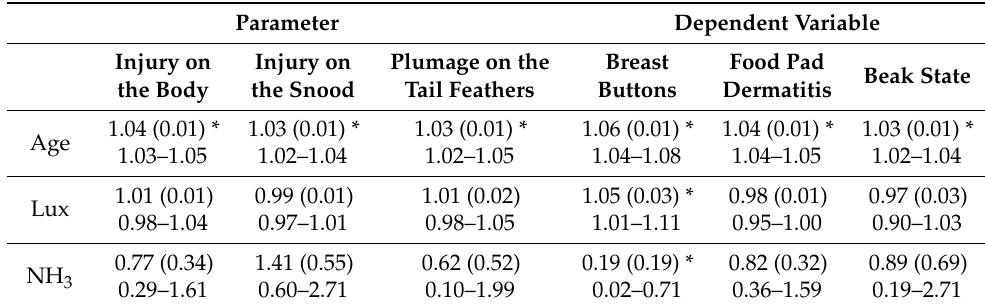
Table 3. Statistical analysis of the relationship between the parameters age, lux (light intensity) and NH 3 (gaseous ammonia content) and the examined welfare indicators ( n = 192). Shown with the odds ratio, the standard error in brackets and the 95% credible interval below. Significant differences are marked with an asterisk.